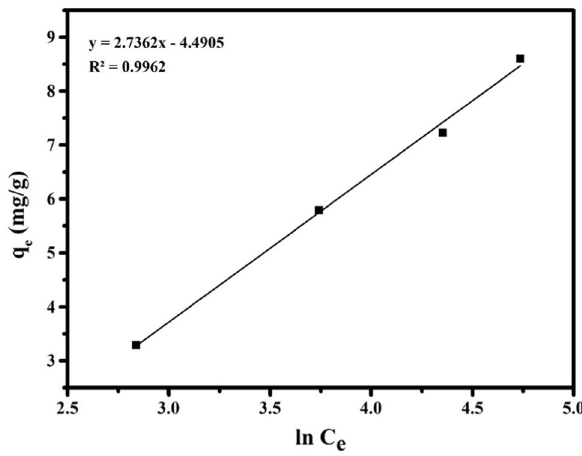
Fig. 9 Temkin adsorption isotherm of MB dye adsorption on the PBF